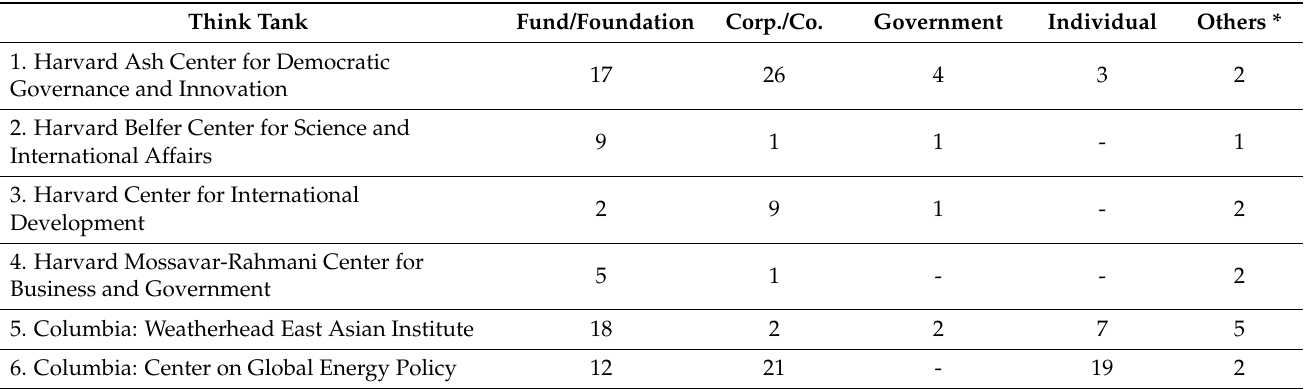
Table 5. Representative funding sources of Ivy League university think tanks (take the think tanks at Harvard and Columbia as a sample). Unit: